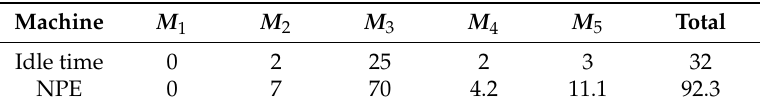
Table 5. The NPE on the machines in the given schedule.